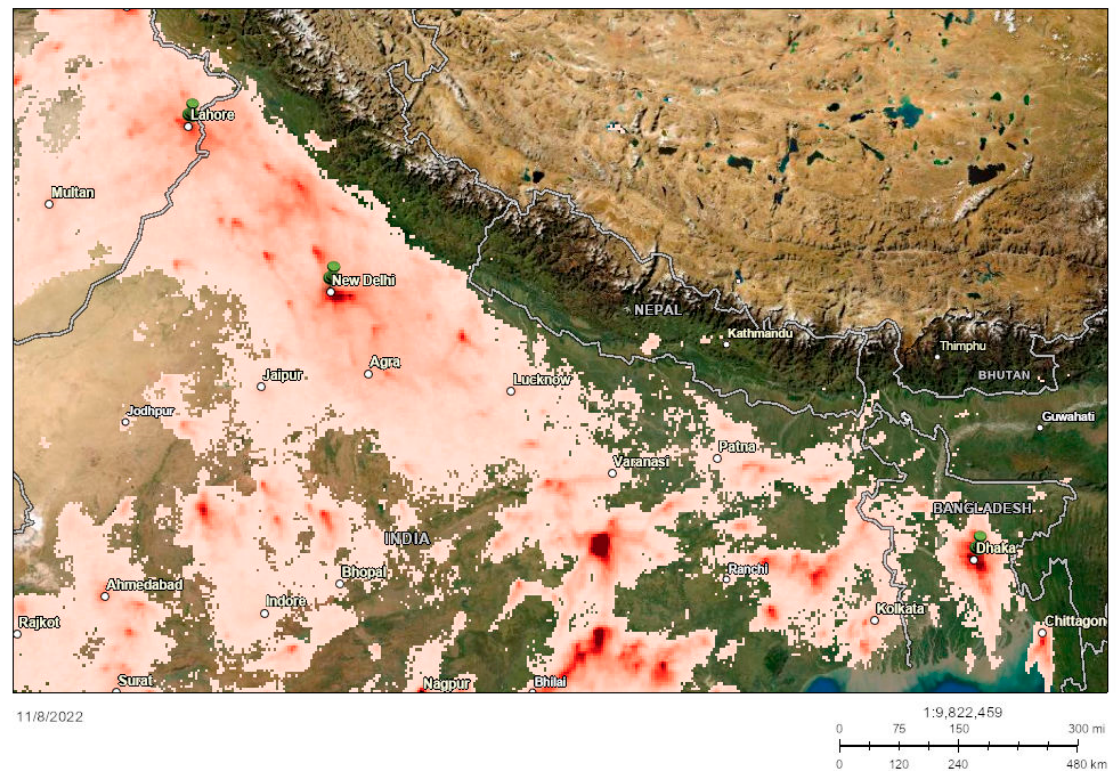
Figure 4. GIS mapping of low air quality geographic ‘spots’ in the South Asian region. The GIS image was generated on 11/8/2022, with data sources comprising the European Commission, European Space Agency, Esri, and the UKRI GCRF South Asian Nitrogen Hub [44,45].